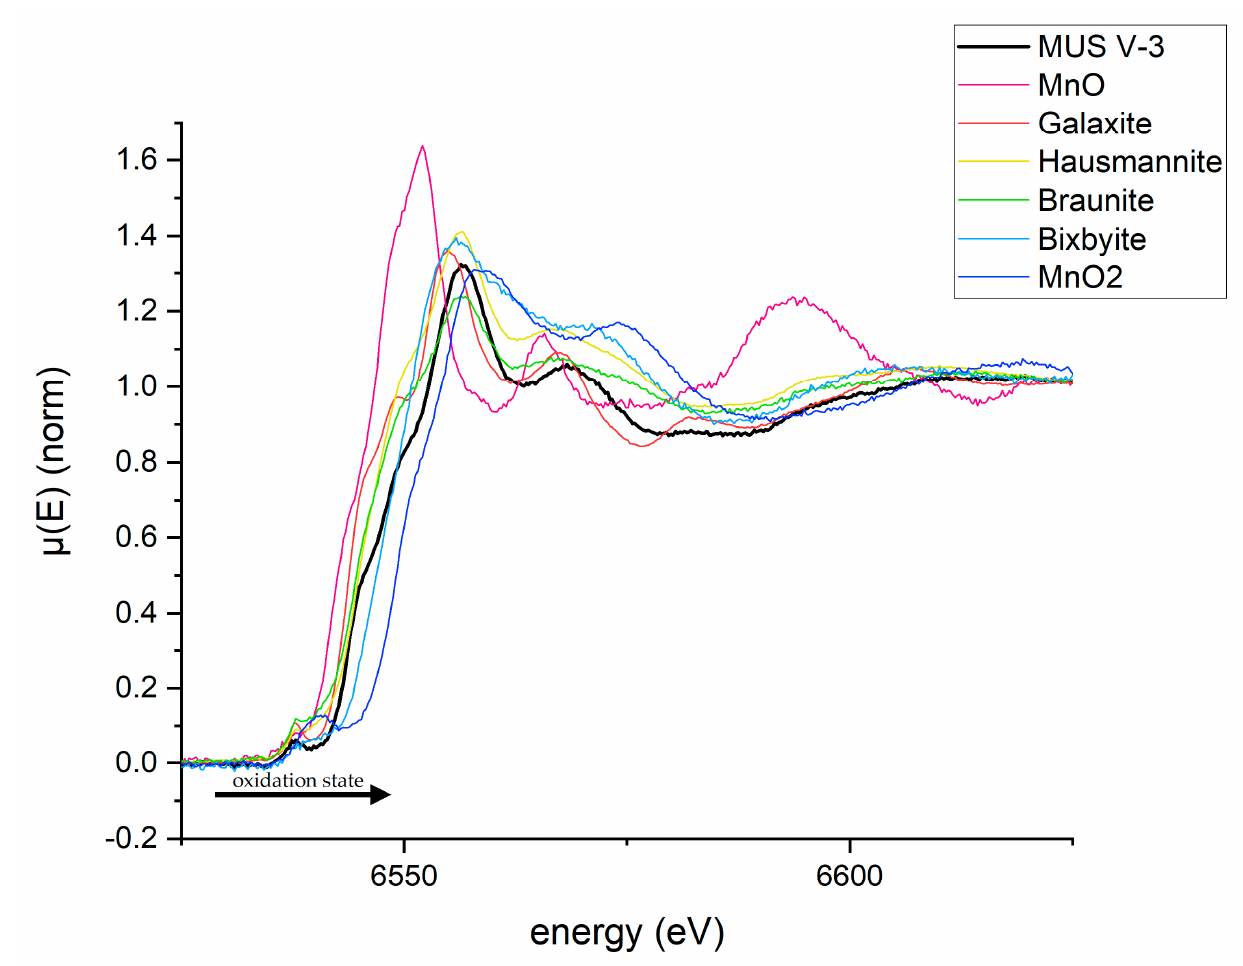
Figure 6. Spectra of Mn samples of different oxidation states. The spectra are compared to the spectrum of the mock-up slag (MUS). A shift of the edge accompanies the increase in the oxidation state which is indicated by the arrow. The mean oxidation states of Mn in the compounds are as follows: MnO: +2; galaxite: +2, hausmannite: +2.67; braunite: +2.85; bixbyite: +3; and MnO 2 : +4.